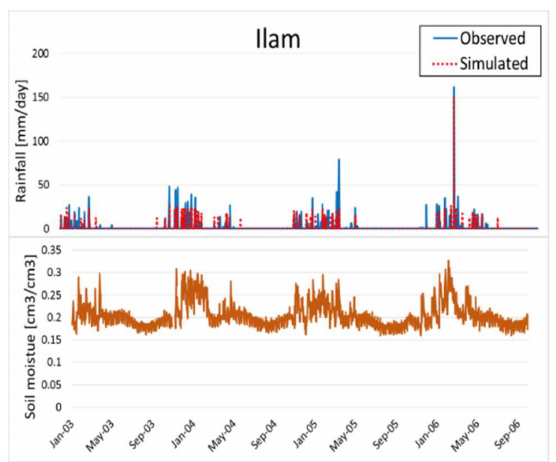
Figure 4. Observed and SM2R-AMSRE- estimated daily rainfall (upper panels) and AMSR-E soil moisture data (lower panels) from January 2003 to October 2006 for the climate stations indicated.